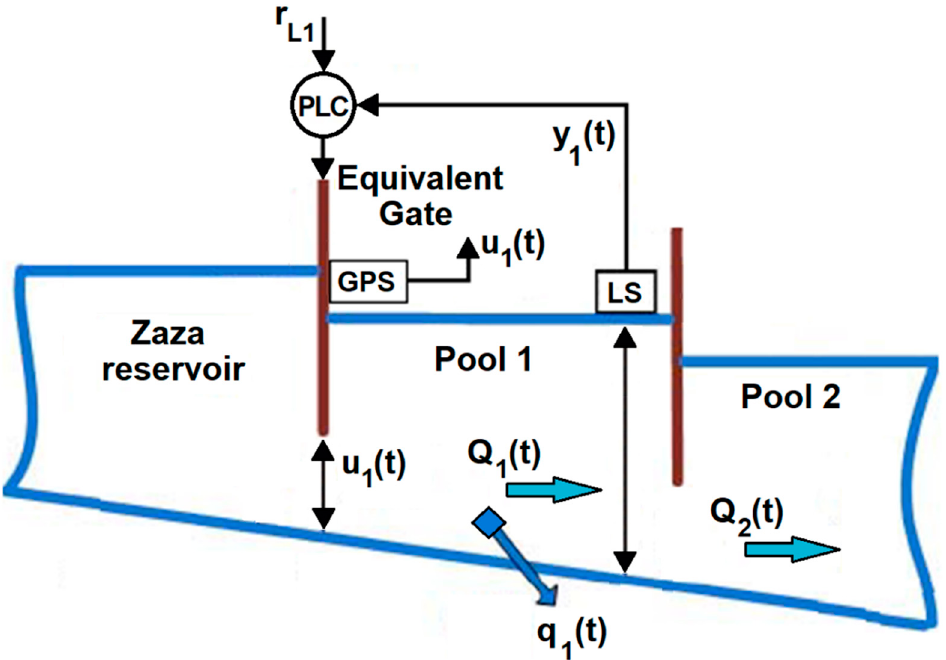
Figure 2. Schematic diagram of the first pool in ZCAMC, where LS is a level sensor, GPS is a gate position sensor, PLC is a programmable logic controller, Q i ( t ) are the water flows; u 1 ( t ) is the gate position, q 1 ( t ) is the lateral discharge, r L 1 is the water level setpoint. The available measurements are the downstream end water levels y 1 ( t ) , and the gate positions u 1 ( t ) . Thus, the controlled variable is the downstream end water level y 1 ( t ) , and the manipulated variable is the position of the upstream equivalent gate 1